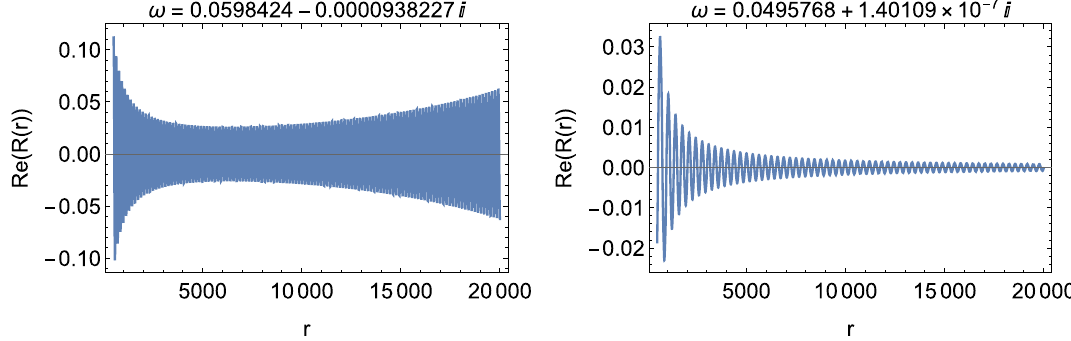
Fig. 2 For the same fixed parameters ( m p , q 1 , q 2 ,(cid:11), Q 1 , Q 2 ) = ( 0 . 045 , 0 . 025 , 0 . 025 , 1 , 1 , 100 ), both stable (left) and unstable (right) normal modes can arise. Here ω r is smaller for the unstable QNM